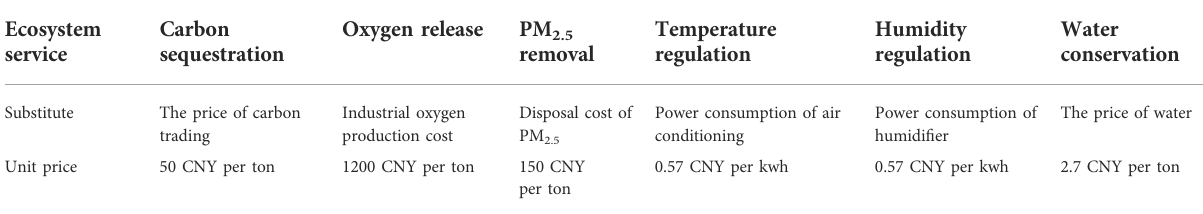
TABLE 2 Value ef fi cient of ecosystem services.